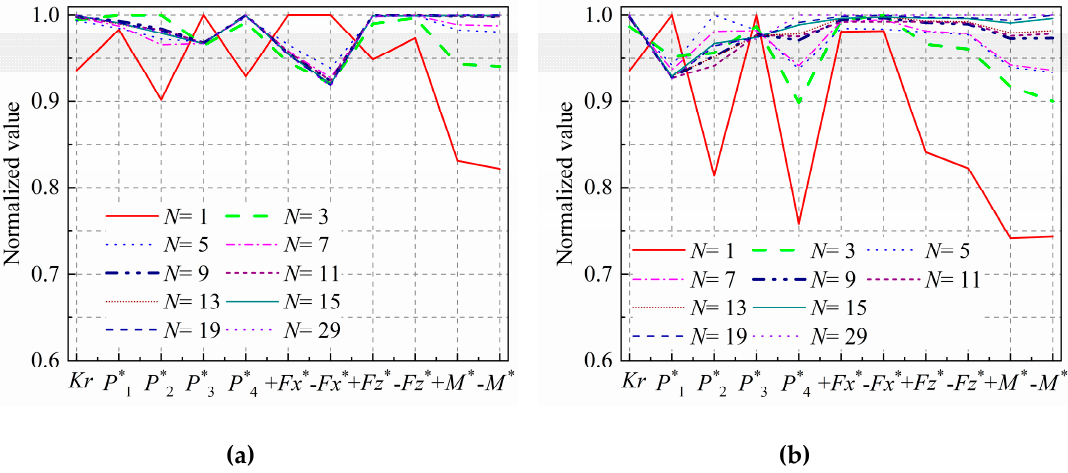
Figure 2. Truncating effect of pressure and wave forces acting on the submerged plate: ( a ) Case 1: k P d = 1.12, A max / d = 0.14, d 1 / d = 0.25, h / d = 0.1, B / d = 2; ( b ) Case 2: k P d = 0.79, A max / d = 0.1, d 1 / d = 0.16, h / d = 0.03, B / d = 1.5 .